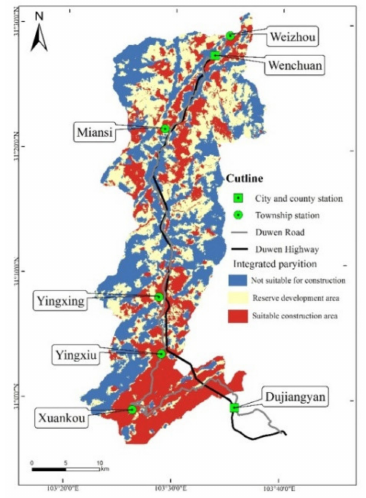
Figure 11. Comprehensive